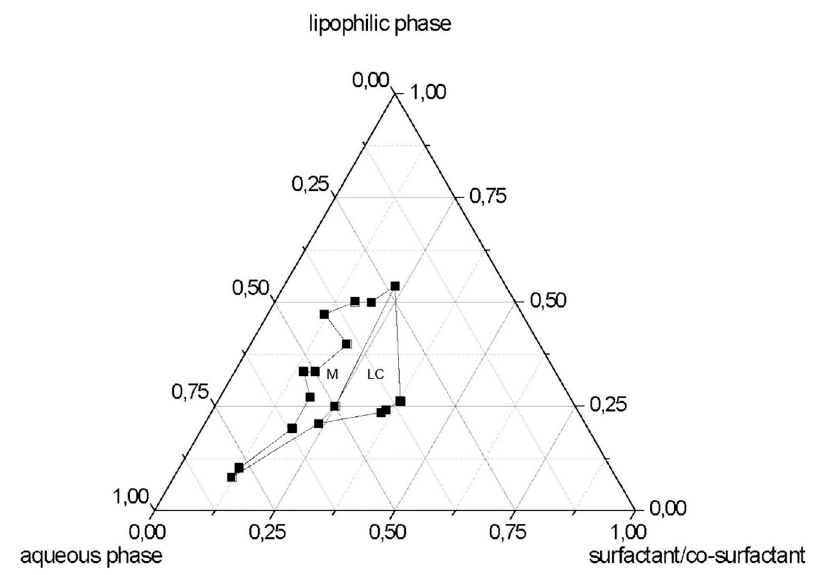
Figure 1. Phase diagram at room temperature (25 °C) of the systems containing lipophilic phase/aqueous phase/surfactant:co-surfactant (trilaurin (TL) solution in EA s /W s -BenzOH/lecithin-PEG-6 hydrogenated castor oil-sodium taurocholate (Na TC). M: µE domain; LC: liquid crystal domain.